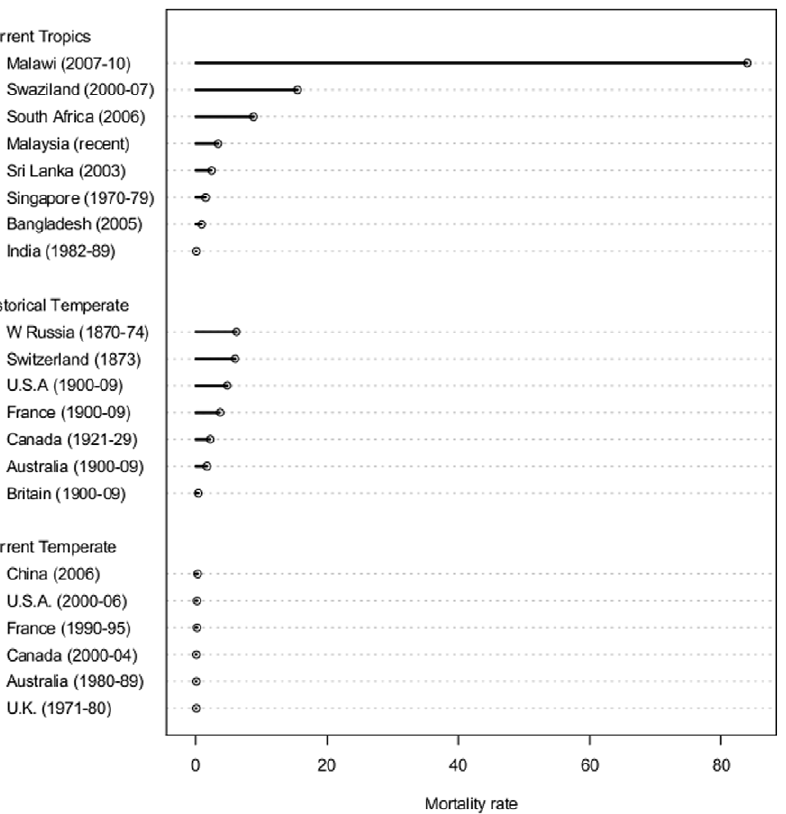
Figure 2. Estimates of mortality from lightning per million people per annum. Data are taken from Holle [1] and were compiled from published estimates, except for Malawi (this study) and Swaziland [5]. Selected data include historical estimates to approximate rates in 1900 ( + / 2 30 yrs). All mortality rates reported for current temperate countries are less than 1.0 per million people per annum.